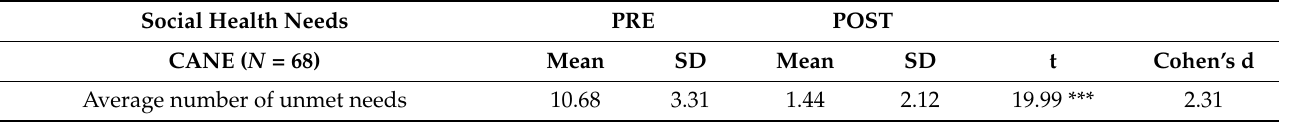
Table 7. CANE. Difference in pre-/post-means of total unmet